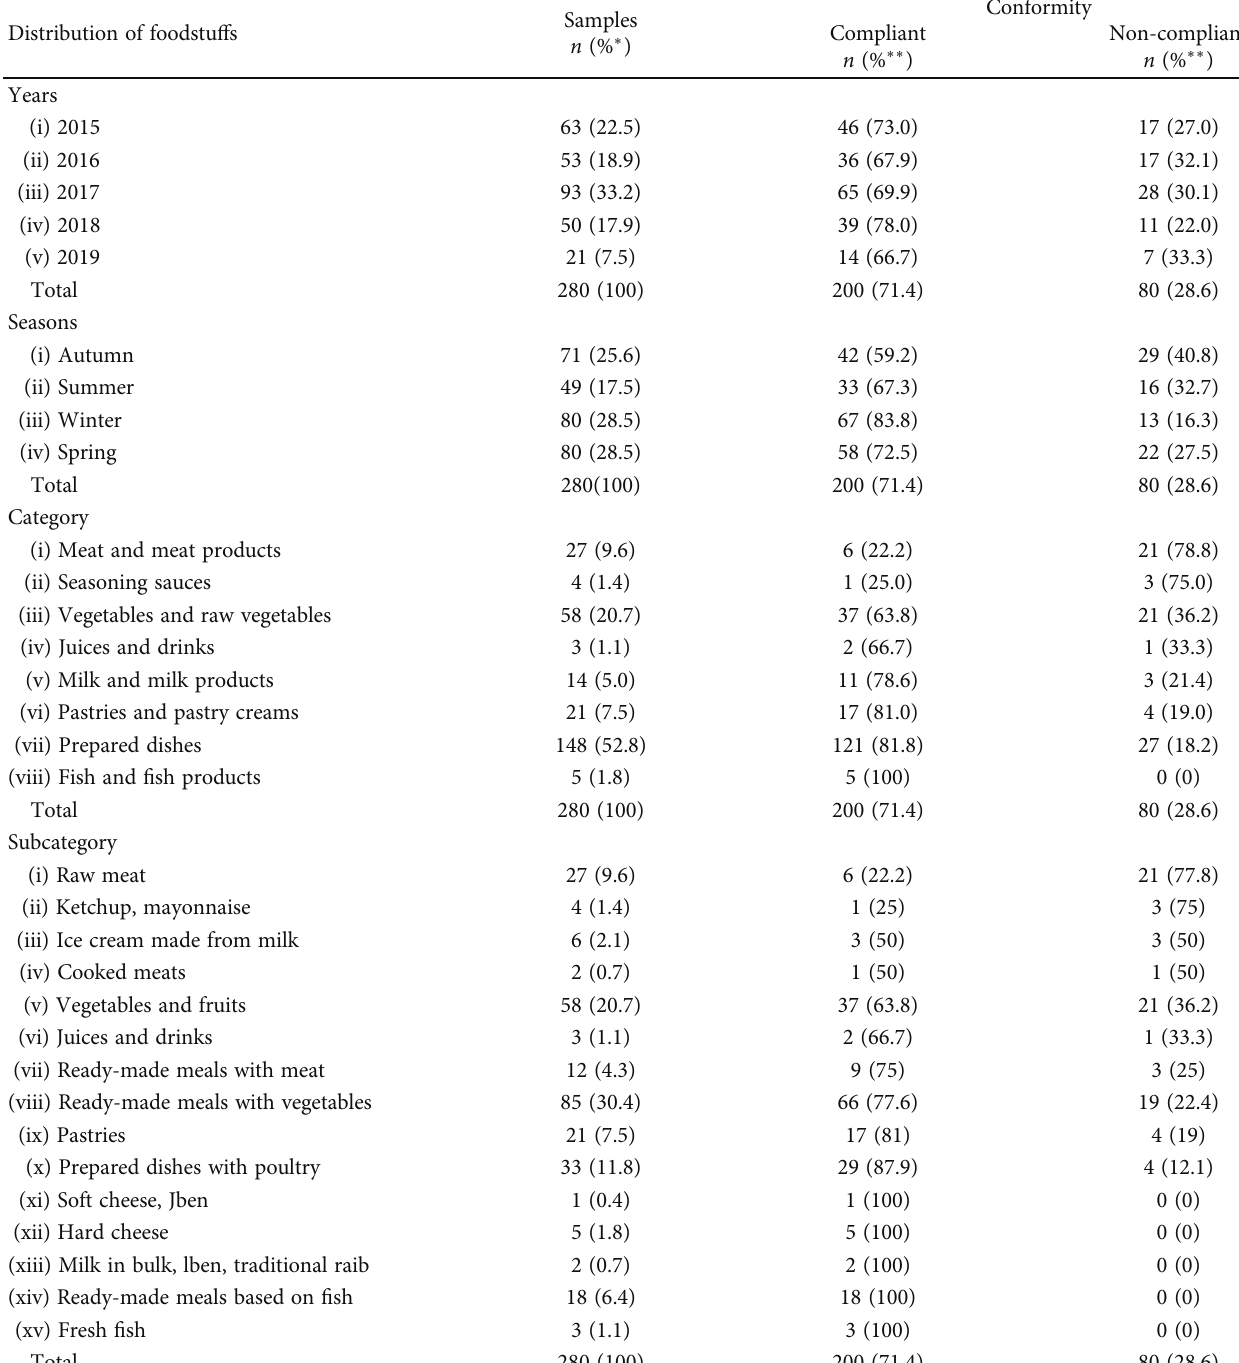
Table 3: Percentage and frequency of non-compliance of foodstu ff s from